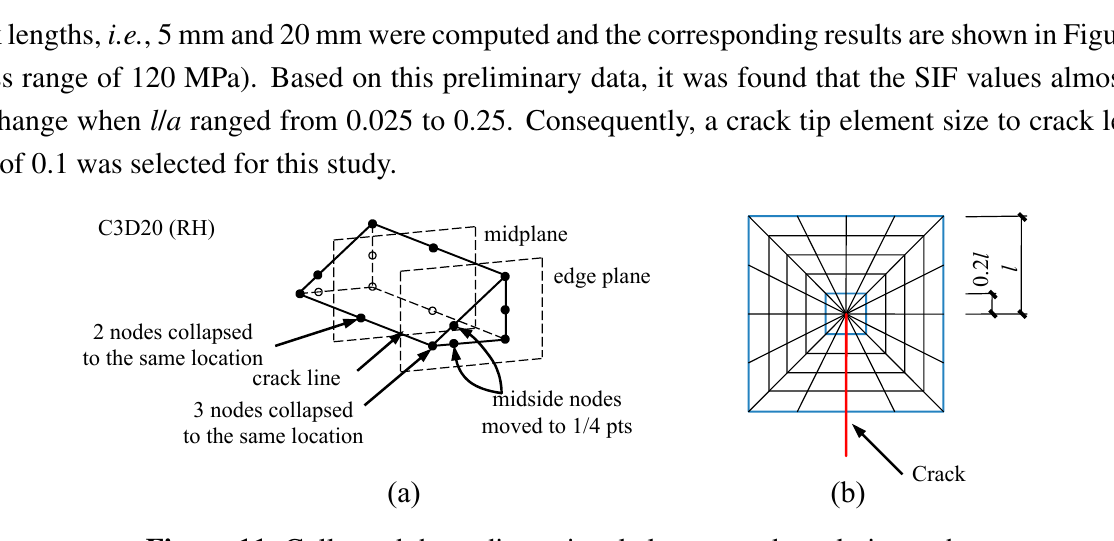
Figure 11. Collapsed three-dimensional element and crack tip mesh.